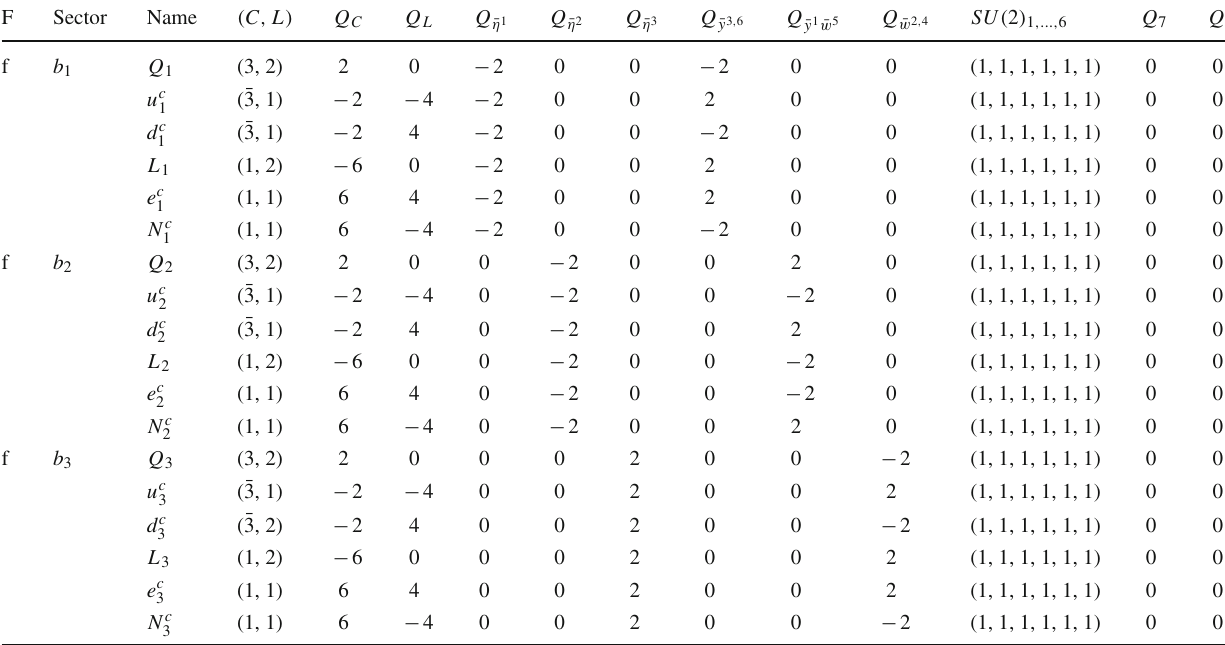
Table 3 The observable matter sectors. All charges are multipled by 4 F Sector